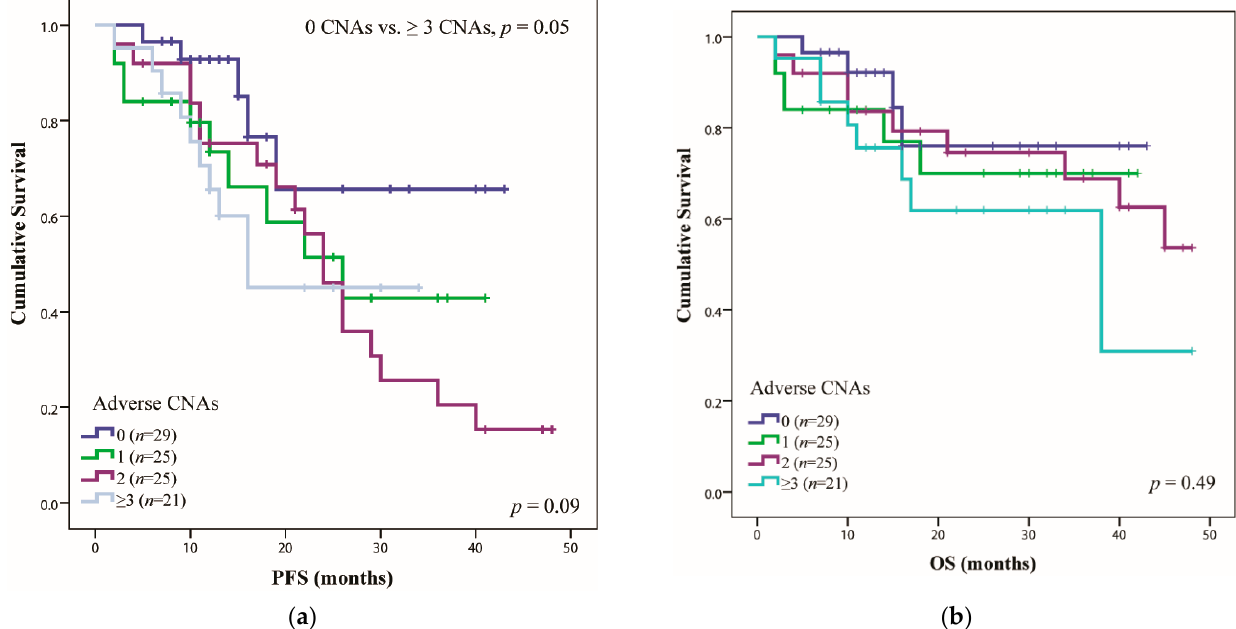
Figure 2. The progression-free survival (PFS) ( a ) and overall survival (OS) ( b ) correlated with adverse CNAs. The median PFS and OS were calculated using Kaplan–Meier analysis for survival time. Where, 0—no adverse DNA damage, 1—one adverse CNA, 2—two adverse CNAs and ≥ 3—at least three adverse CNAs.